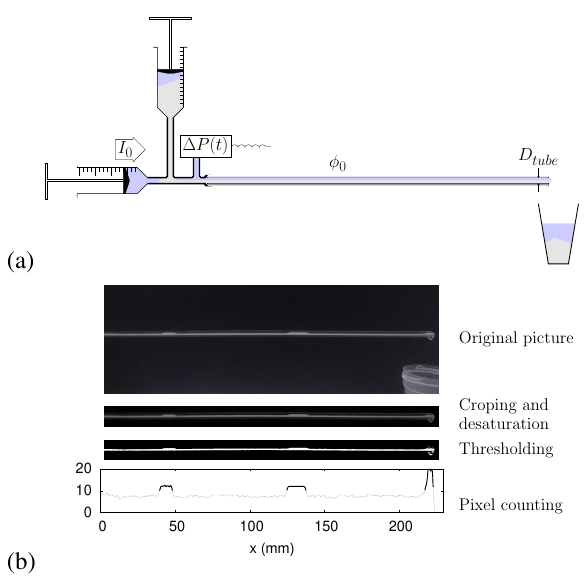
Figure 1. (a) Schematics of the experimental setup. (b) Steps illustrating the image treatment procedure from original image to granular matter